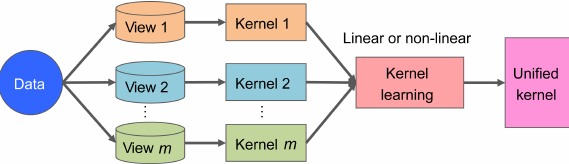
Fig. 3 Co-training approach for multi-view spectral clustering [28] . Fig. 4 General procedure of multi-kernel